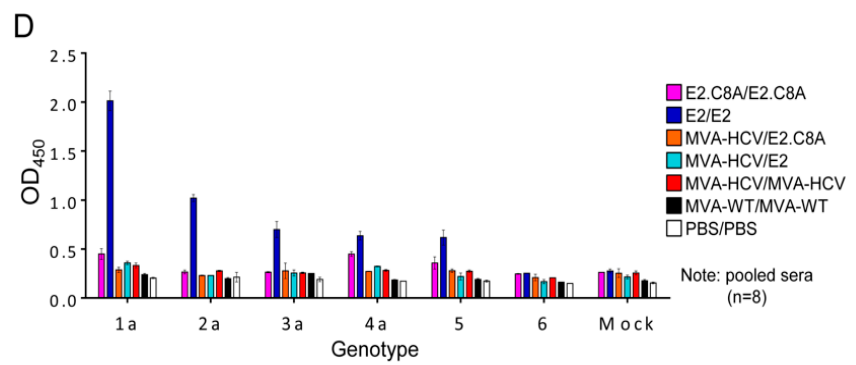
Figure 8. Binding reactivity and neutralization activity of the mice sera. ( A ) Total IgG binding levels against E2 aggregates (left panel) or E2.C8A monomers (right panels) in pooled serum from immunized mice at 10 days post-boost. ( B ) A pilot neutralization experiment comparing the inhibitory activity of serially diluted mice sera obtained from a previous immunization with DREP-HCV/MVA-HCV, MVA-HCV/MVA-HCV, and MVA-WT/MVA-WT [25] and the corresponding purified IgG samples against H77 HCV pseudo particles (HCVpp). ( C ) Neutralization assay curves showing inhibition of H77 HCVpp infectivity by serially diluted purified IgG of four mice sera from immunized mice with E2/E2, E2.C8A/E2.C8A and MVA-HCV/E2 at 10 days post-boost. ( D ) Binding of pooled sera (at a 1/50 dilution, n = 8 mice/group) from the adaptive phase (10 days post-boost) to lysed HEK293T cells expressing core-E1-E2 from different HCV genotypes was determined by ELISA.